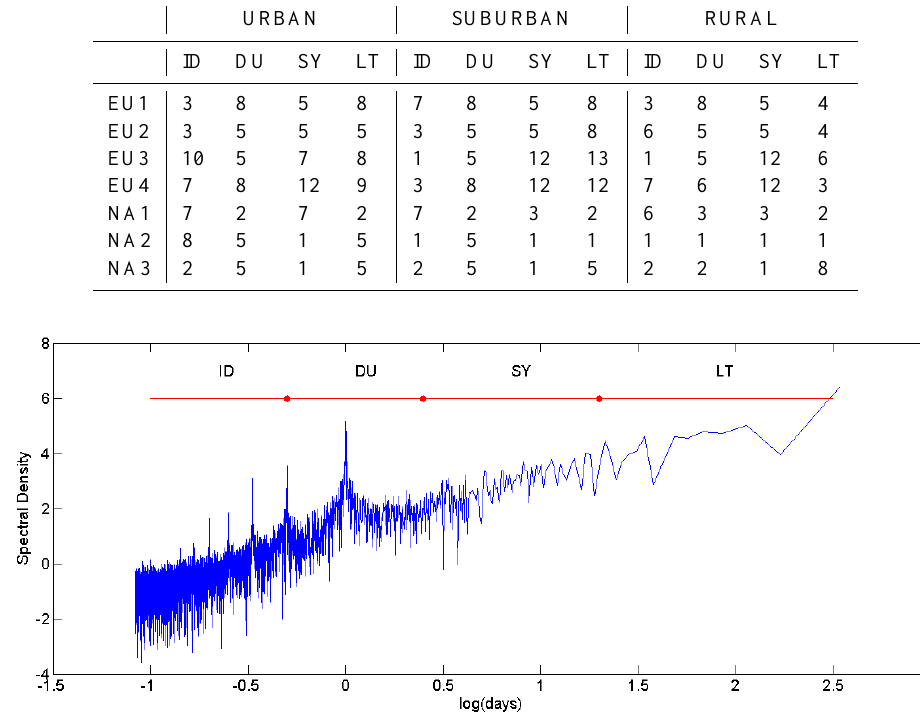
Fig. 5. Periodogram of the observed ozone concentrations (aggregated over rural stations) in the EU1